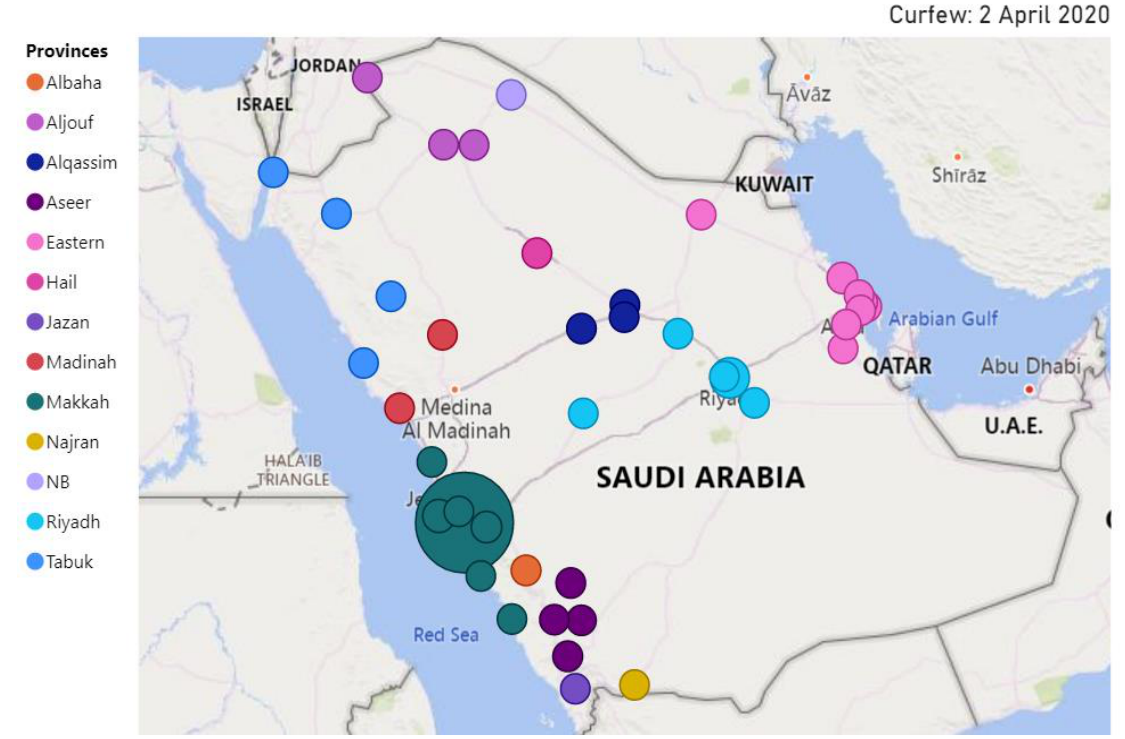
Figure 13. Spatio-temporal behavior of public concern (curfew: 2 April 2020).